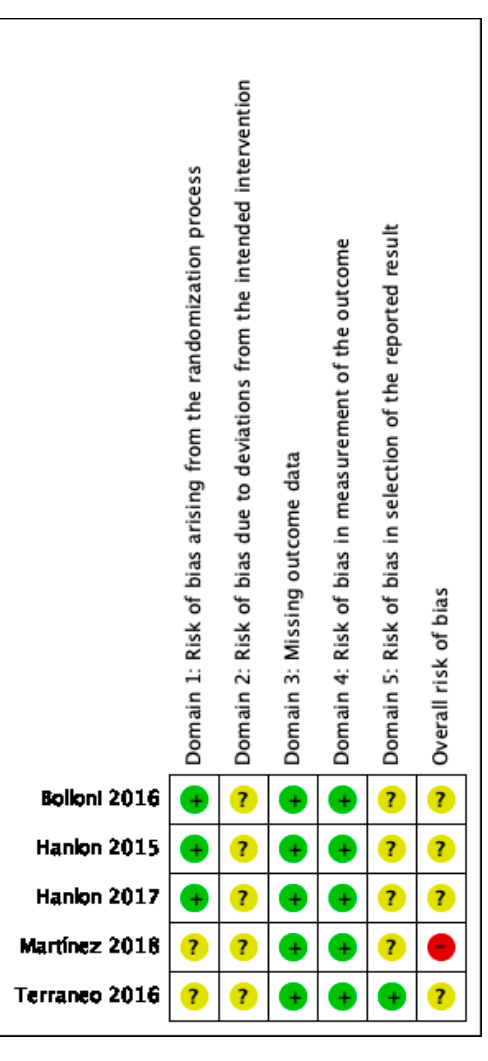
Figure 2. Risk of bias summary.